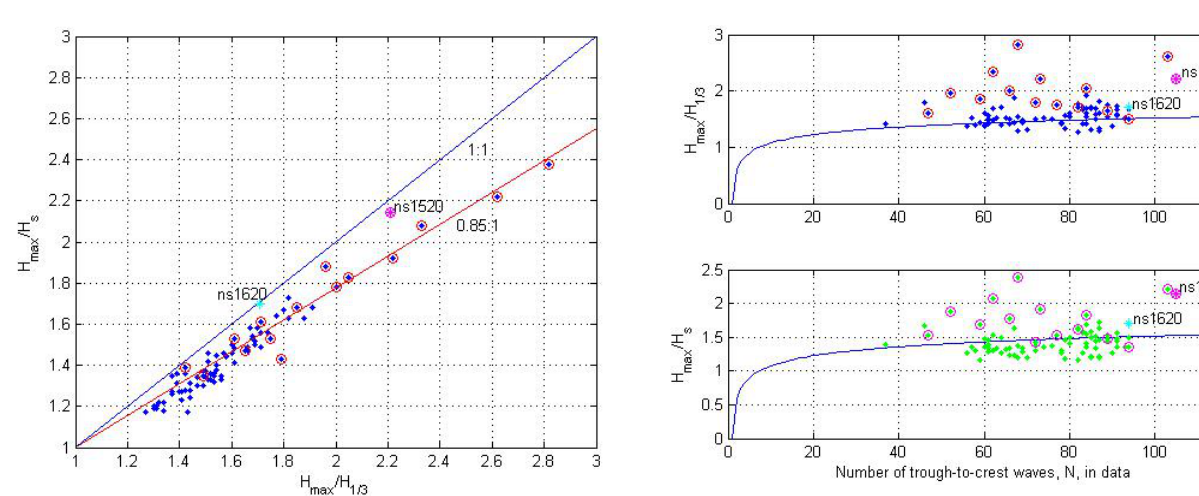
Figure 7. Time history of wave heights during Typhoon Krosa. For the three digit numbers on the abscissa, the first number is the day of October and the next two digits give the corresponding hour. The red vertical bars denote where freaque waves might have occurred.